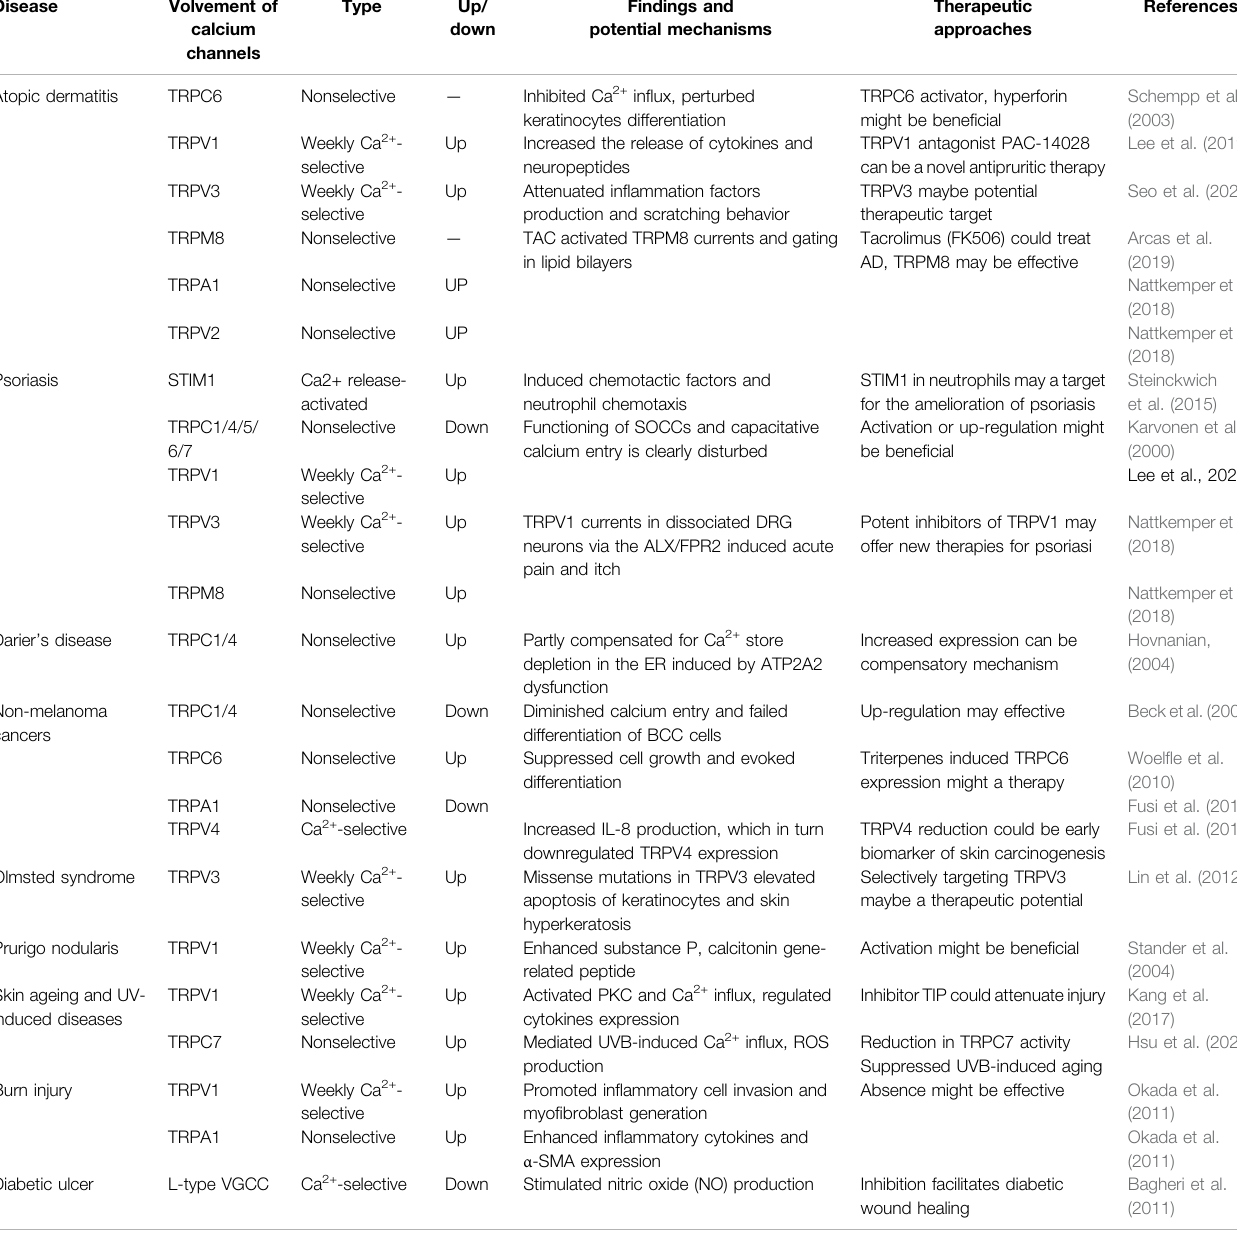
TABLE 1 | Role of TRP and SOC channels in several dermatologic diseases.